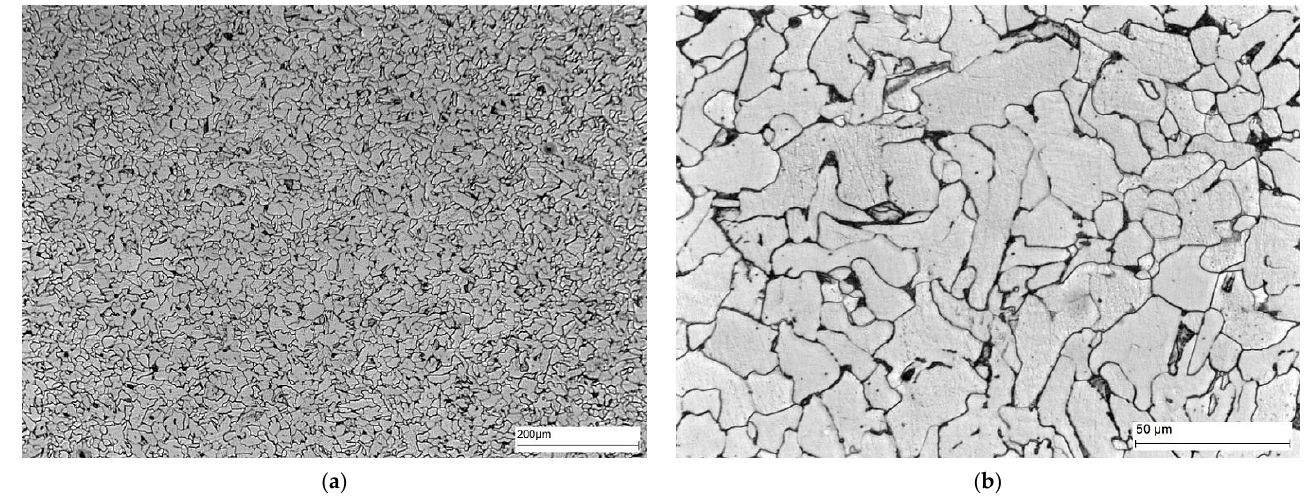
Figure 14. Microstructure of area A of the welded joint—parent material: ( a ) 100× magnification, and ( b ) 500× magnification. Ferrite—white precipitates, and perlite—dark precipitates at the ferrite grain boundaries.